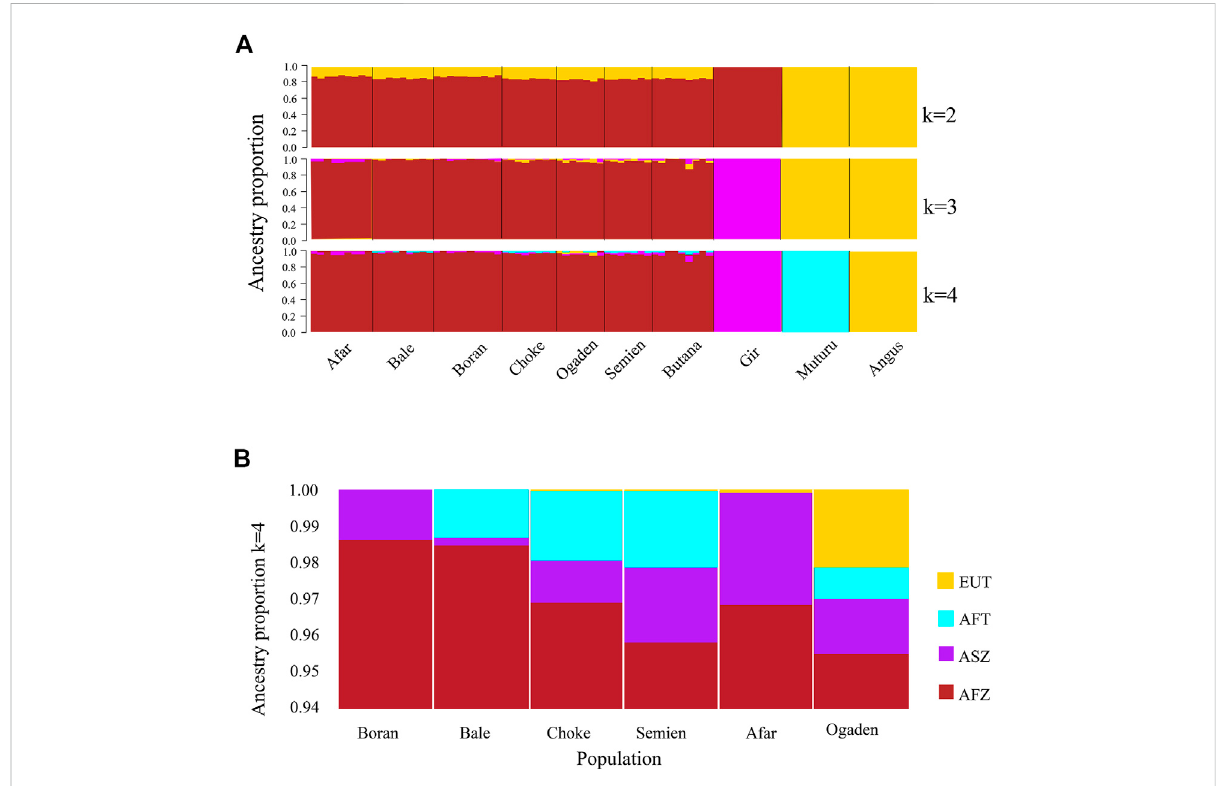
FIGURE 3 The plot of population genetic admixture analysis. (A) Cattle population in the whole dataset and (B) Ethiopian cattle ancestry